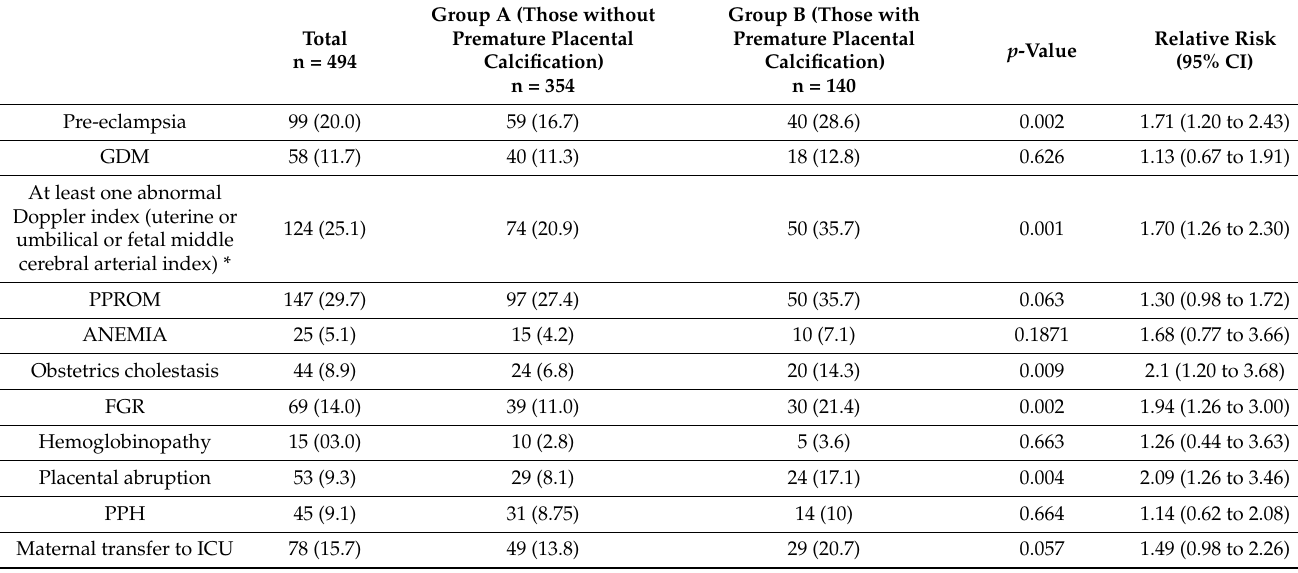
Table 2. The maternal outcome for the selected cohort of pregnant